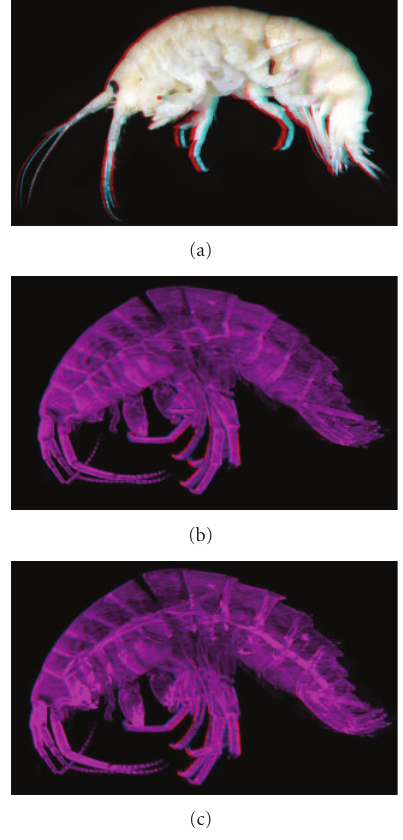
Figure 3: Stereo images of entire gammaridean specimens (use red-cyan glasses to view). (a) Red-cyan stereo anaglyph based on a pair of macrographs of Dikerogammarus villosus recorded under slightly di ff erent angles. (b)-(c) Images of Gammarus roeselii based on a micro-CT scan. (b) Volume rendering. This presentment emphasizes the outer surface structures. (c) Maximum intensity projection. This presentment enhances the inner structures, as outer surface structures appear